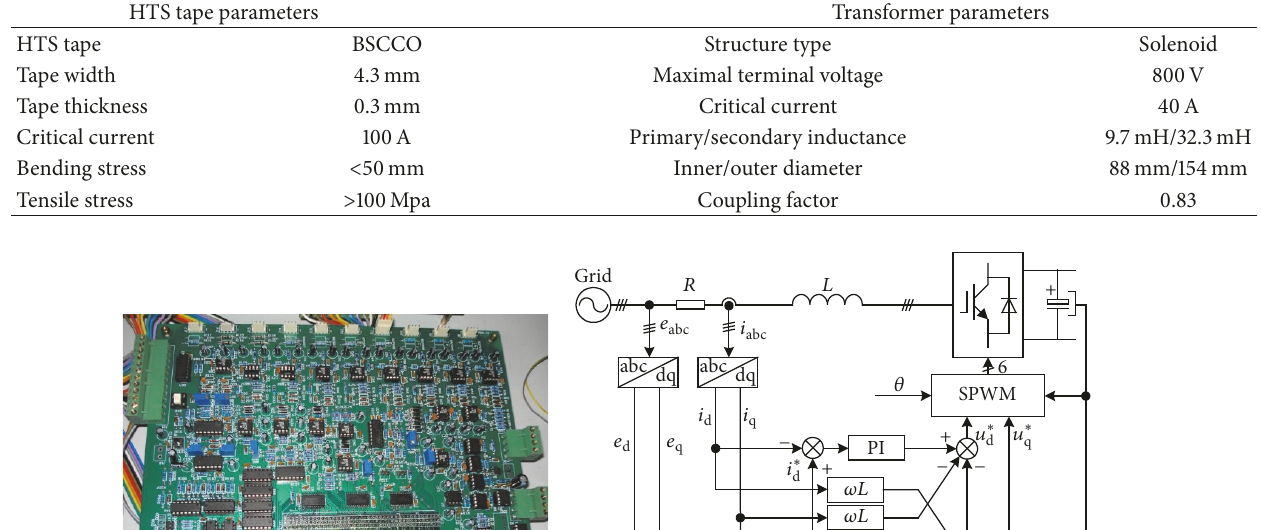
Table 1: Specifications of a single-phase superconducting transformer.